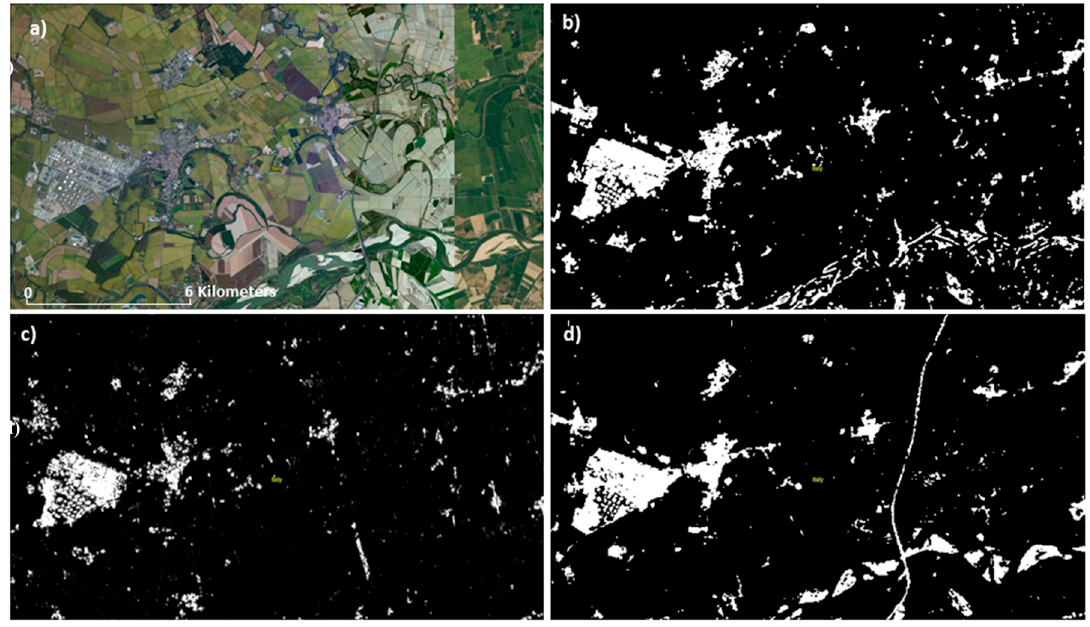
Figure 6. ( a ) The Google earth image of the area under study is displayed here with the: ( b ) results of the SML classifier applied on Sentinel-2 and ( c ) Sentinel-1 compared to ( d ) the GHSL derived from Landsat imagery.